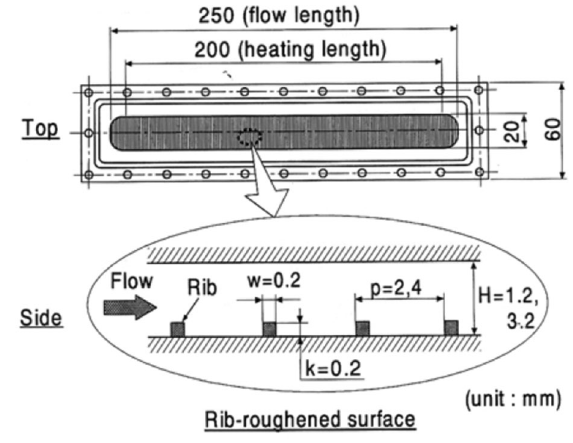
Fig. 1 The experimental setup (rib-roughened narrow channel) from the study of Islam et al.